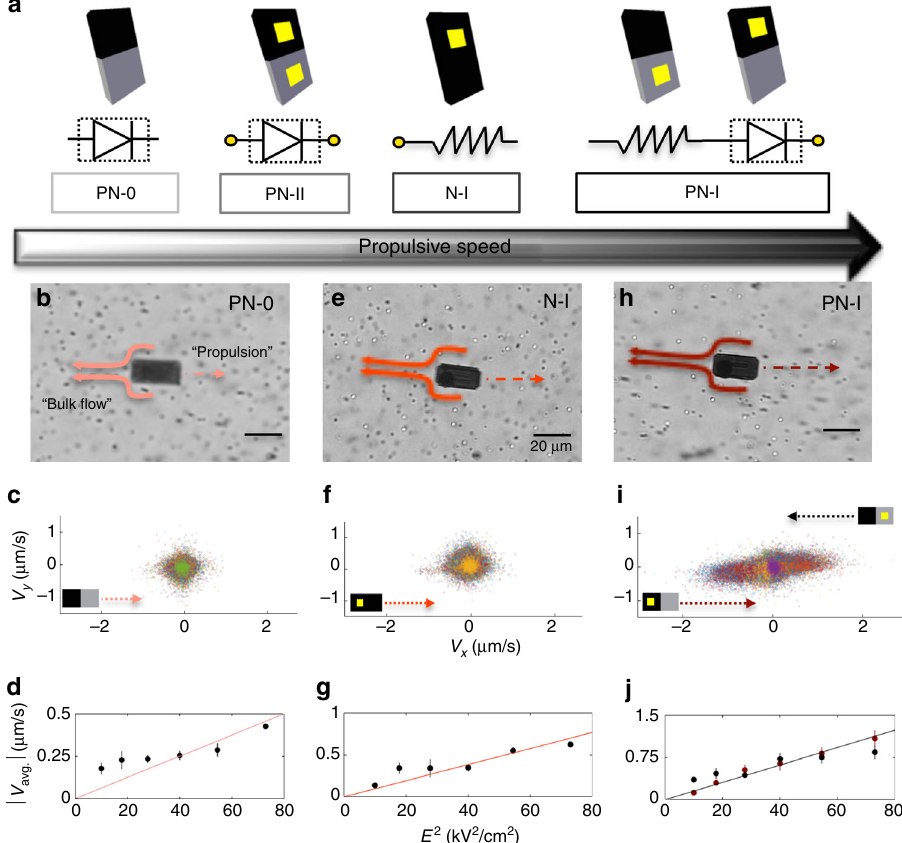
Fig. 2 Hydrodynamic analyses of the fl ows driven by PN-0, N-I, and PN-I microparticles. a Electrical device representations and equivalent circuit diagrams of different types of microparticles (in order of propulsive speed): PN-0, PN-II, N-I, and PN-I. b Tracer beads fl owing around a PN-0 microparticle at a fi xed